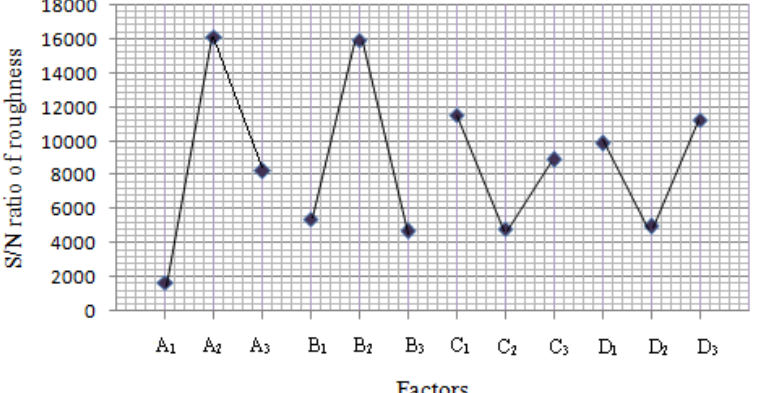
Figure 4. Analysis of effects of control parameters and interaction on S/N for surface